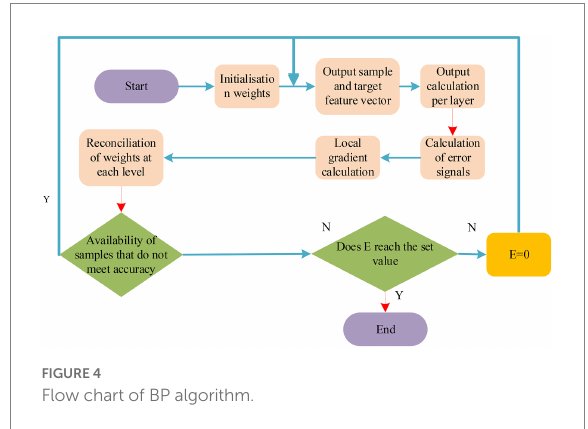
FIGURE 4 Flow chart of BP algorithm.